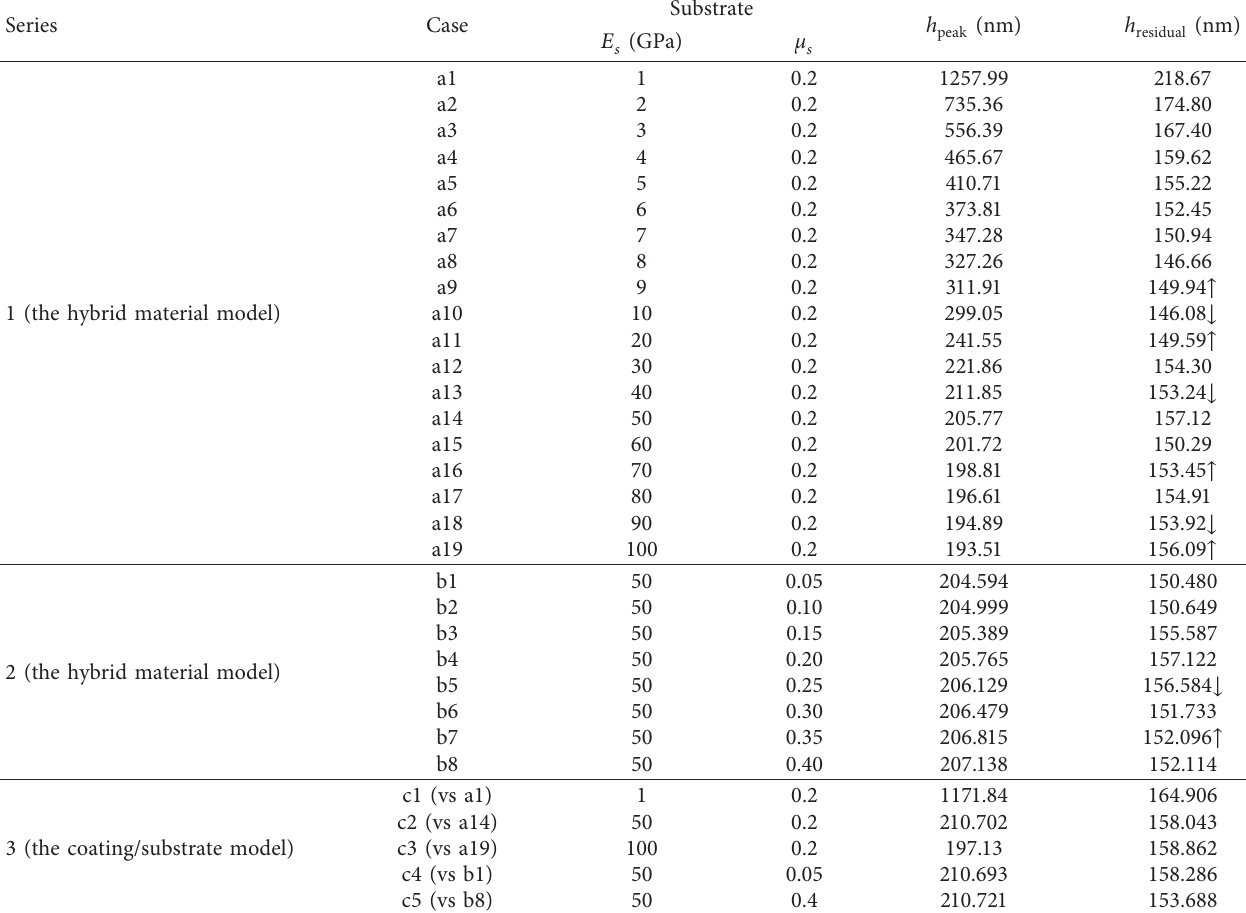
Table 3: Design of the numerical experiment and computation